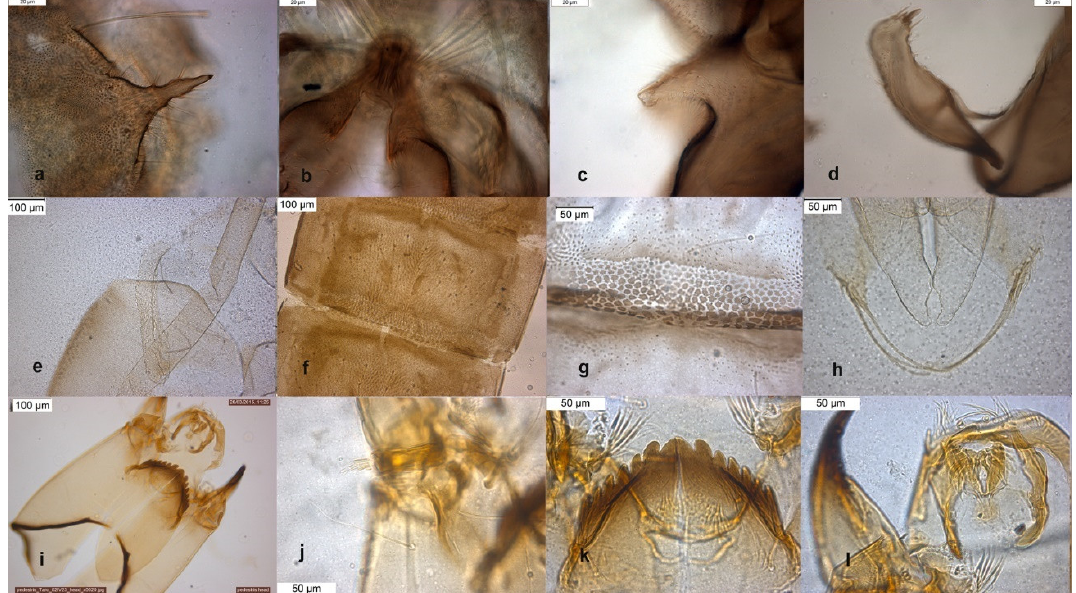
Figure 5. Morphological characters of O. pedestris adult male: ( a ) anal point; ( b ) virga and superior volsella; ( c ) inferior volsella; ( d ) gonostylus; pupal exuvia: ( e ) thoracic horn, ( f ) tergite IV; ( g ) sternite IV; ( h ) anal macrosetae; larva: ( i ) head; ( j ) antenna; ( k ) mentum; ( l ) labrum.